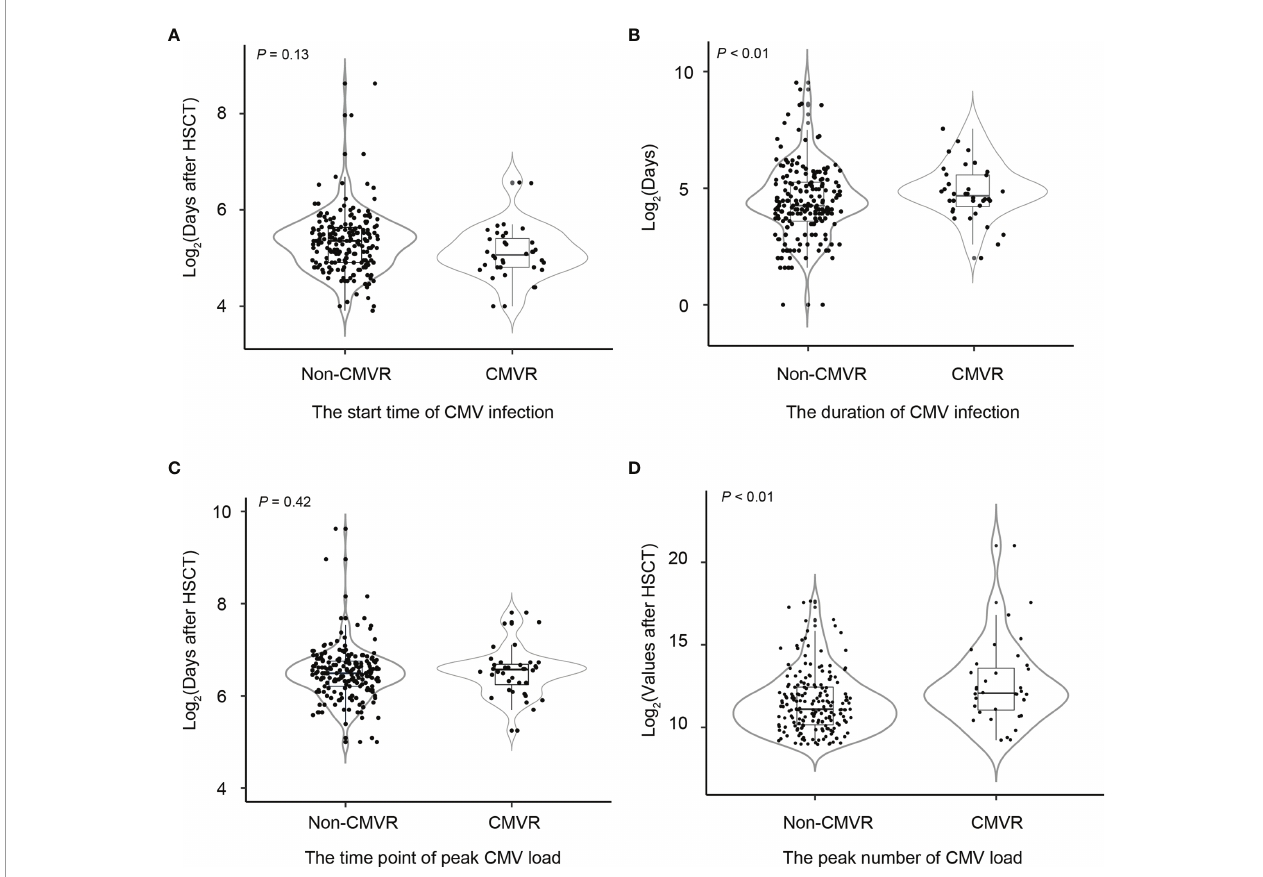
FIGURE 1 | Comparisons of the start and duration time of cytomegalovirus (CMV) infection, the peak number of CMV copies, and the time point of peak CMV load between non-CMV retinitis (CMVR) patients and CMVR patients in severe aplastic anemia patients after hematopoietic stem cell transplantation (A – D) . Non-CMVR in this fi gure referred to patients with CMV infection but no retinitis (n = 195). The number of CMVR patients was